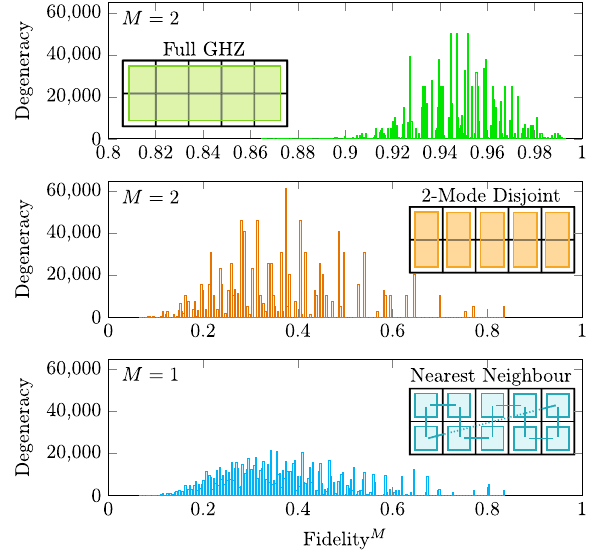
Fig. 6 CV-GHZ fi delity degeneracies. Histograms of fi delity degeneracies for unequal m = 10 pure-loss channel patterns over the complete image space of binary channel patterns U 10 , for a selection of probe-domain distributions: m -mode CV-GHZ state (green), disjointly distributed TMSV states (orange) and nearest- neighbour distributed TMSV states (blue). The fi xed block protocols are using M = 2 probe copies, whereas the dynamic nearest- neighbour protocol is using M = 1 copies. In this way, the average channel use of all the protocols is the same, M ¼ 2